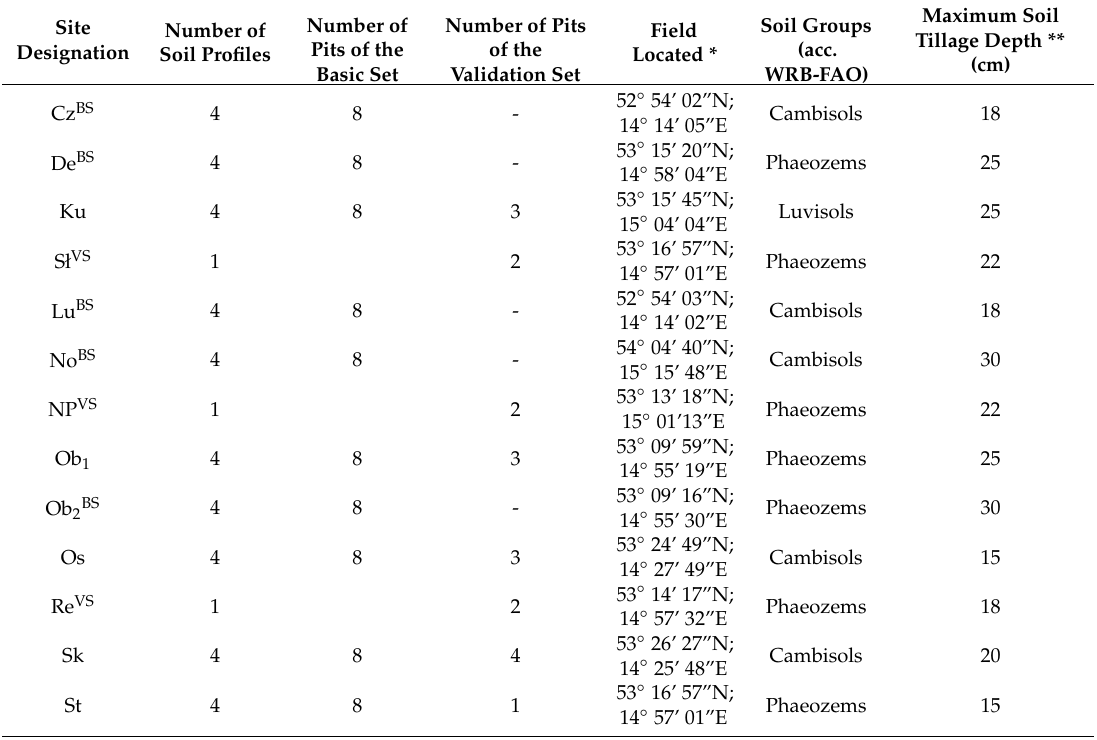
Table 1. Number of profiles and pits per site, the location of arable fields of individual sites and soil cultivation